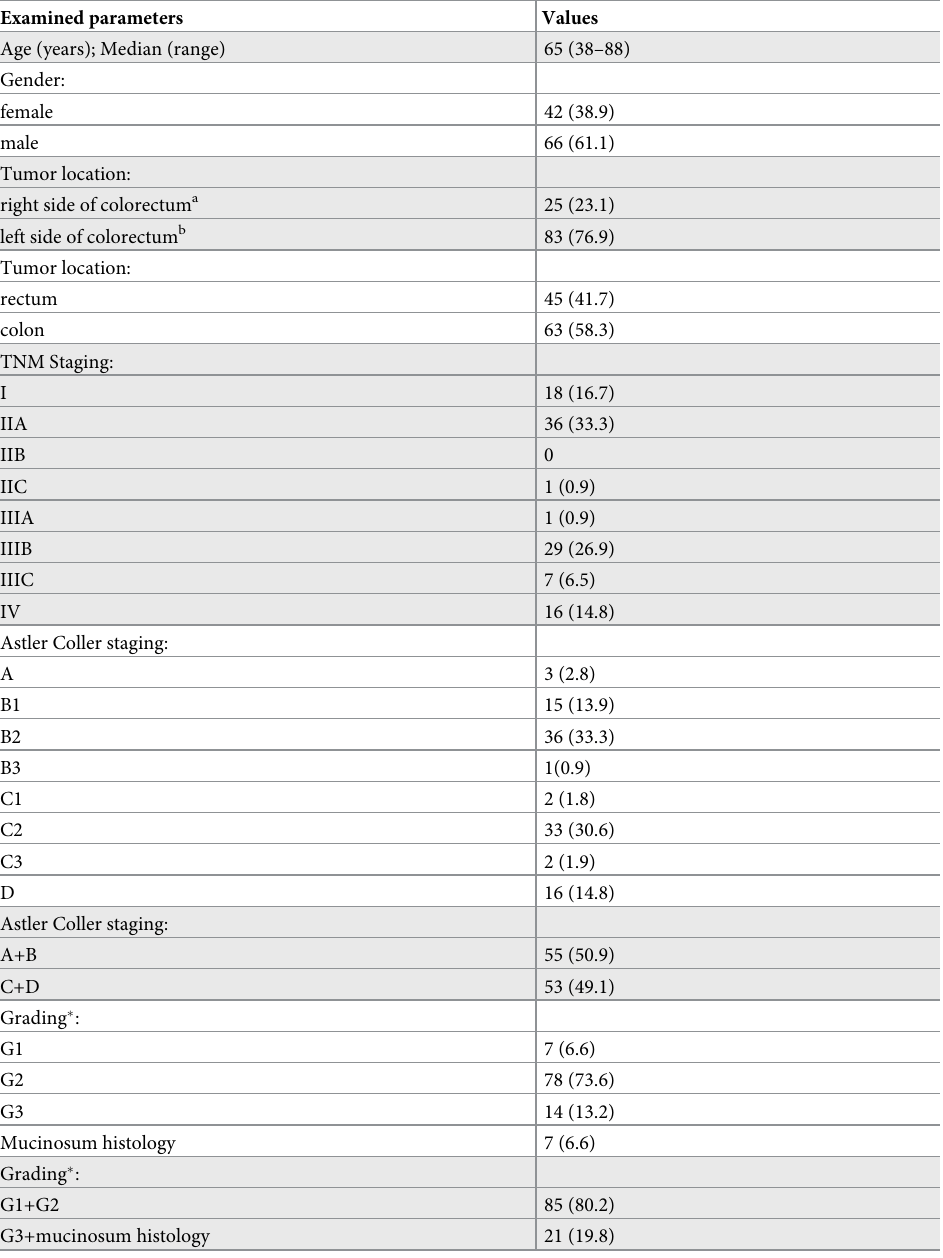
Table 1. Characteristics of patients with colorectal cancer (n =